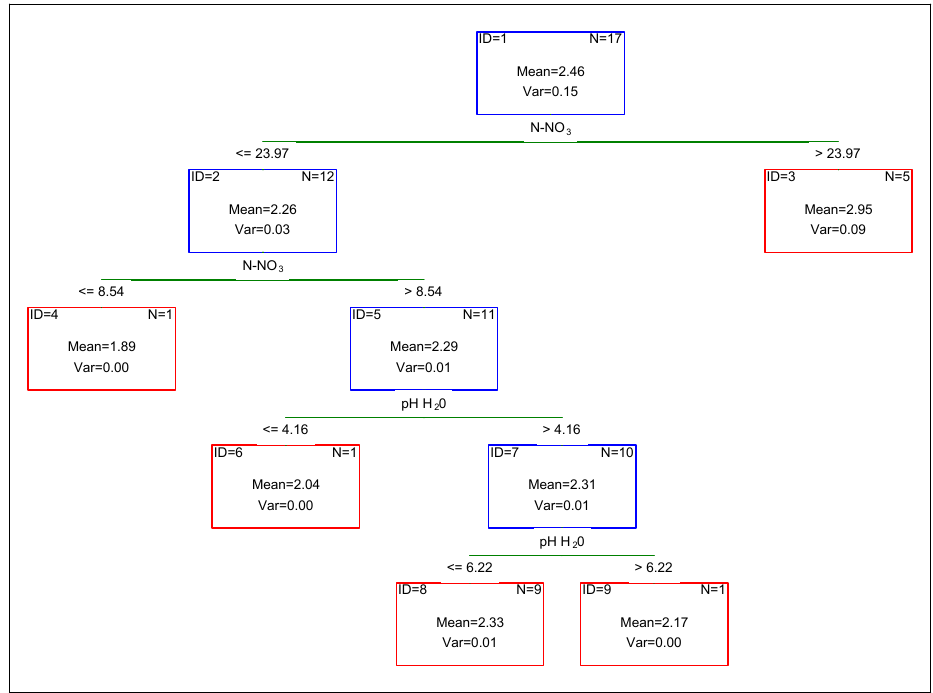
Figure 2. The regression tree (C&RT) for nitrogen content in birch leaves.